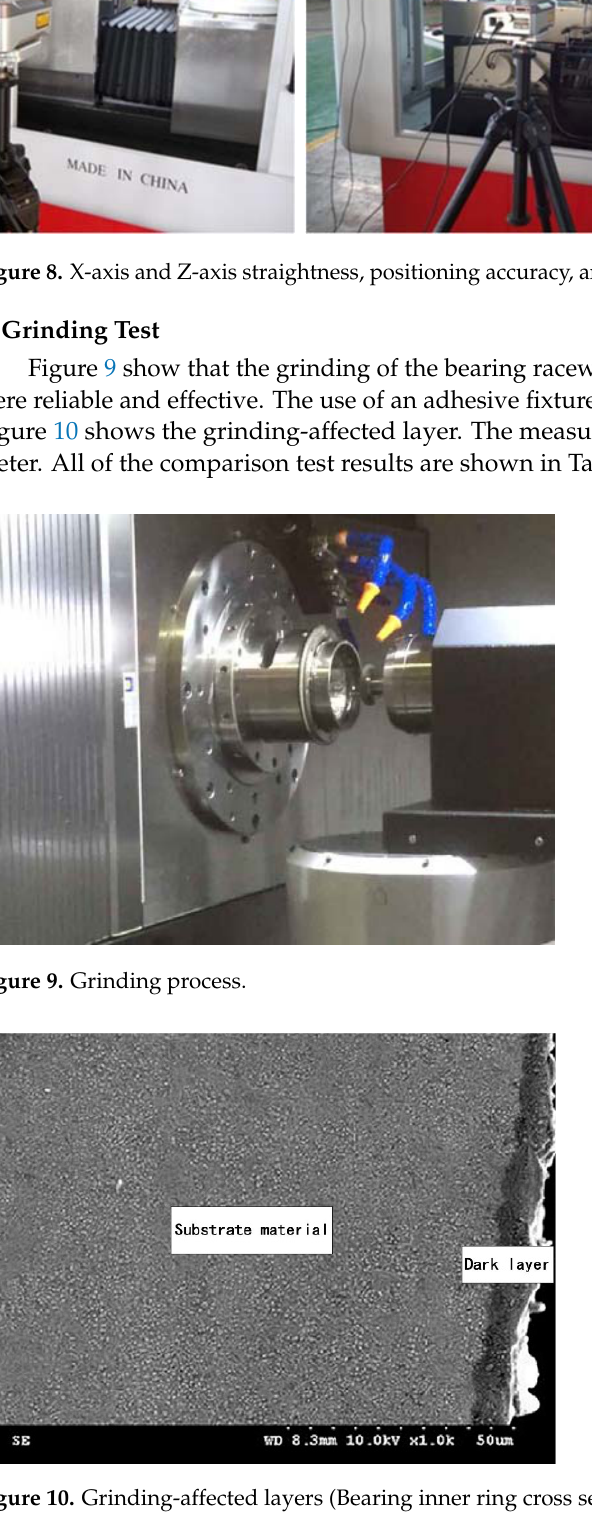
Figure 7. Spindle rotation accuracy detection.